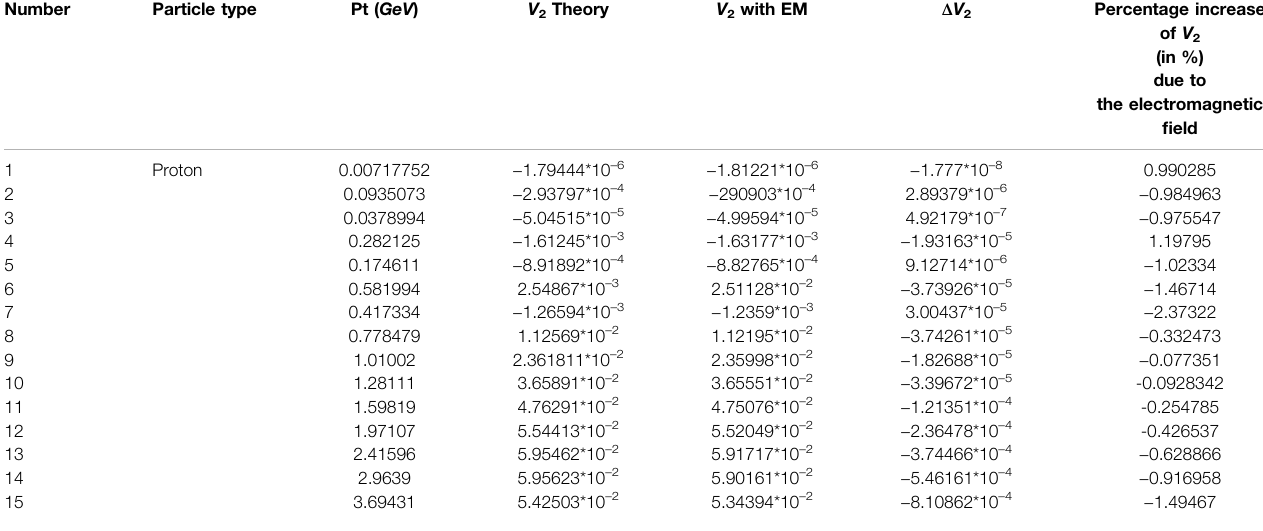
2 )isthedifferencebetween